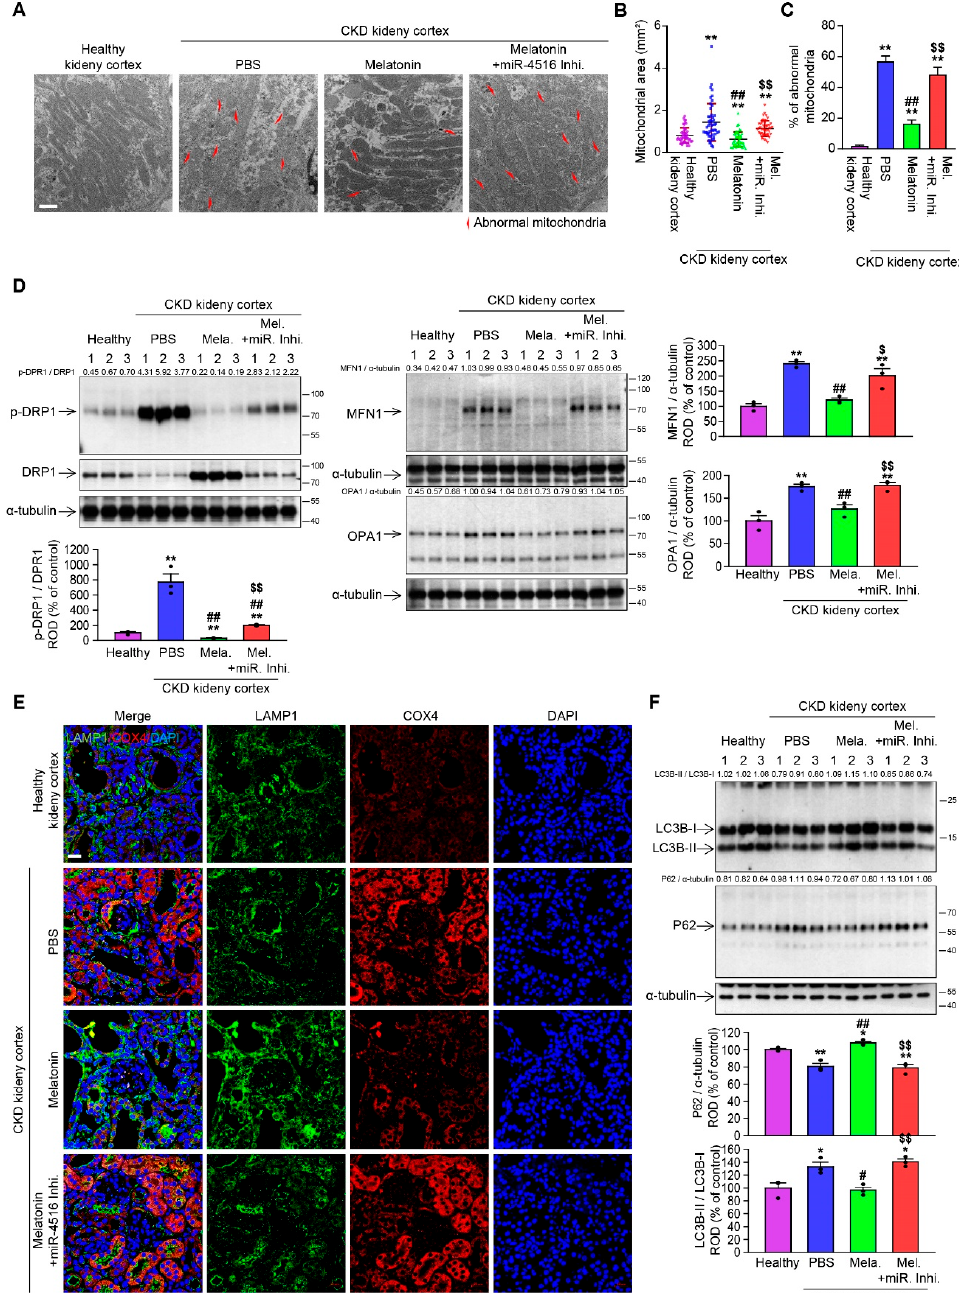
Figure 4. Melatonin-induced miR-4516 improves mitochondrial dynamics and enhances PINK1/Parkin-mediated mitophagy in the CKD mouse model. ( A ) Representative TEM images of mitochondria in renal cortex of CKD mice either treated with melatonin (0.2 mg/kg), or both melatonin and miR-4516 inhibitor (300 nM). Each group received two intraperitoneal injections per week (every 3–4 days)—a total of 4 injections for 2 weeks. All comparisons were made against healthy kidney control (scare bar = 1 μ m) ( B , C ) Measurement of mitochondrial area and number of abnormal mitochondria in renal cortex of each groups (n = 3). ( D ) The expression of p-DRP1, DRP1, MFN1, and OPA1 in renal cortex of each group. Protein expression level were quantified by densitometry and normalized to DRP1 or α -tubulin levels (n = 3). ( E ) Immunofluorescence staining for LAMP-1 (green) and COX4 (red) in renal cortex of each group. Scare bar = 20 µ m. ( F ) Expression of LC3B-II/LC3B-I ratio and P62 in renal cortex of each groups ( n = 3). The values represent mean ± SEM, * p < 0.05, ** p < 0.01 versus healthy kidney cortex; # p < 0.05, ## p < 0.01 versus PBS; $ p < 0.05, $$ p < 0.01 versus melatonin. The α -tubulin was used as Western blot loading control for whole tissue